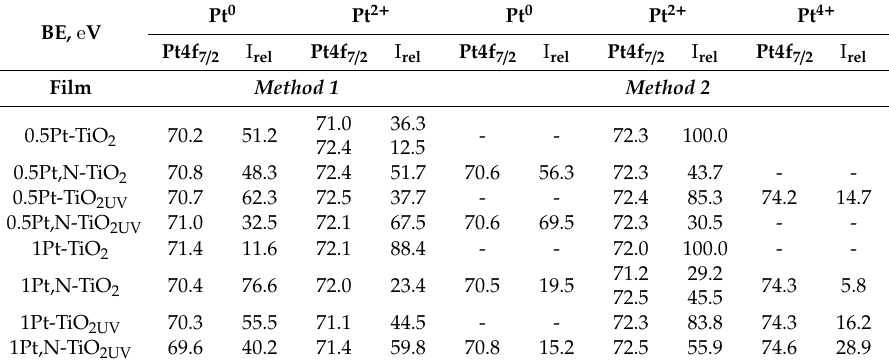
Figure 6. Pt4f XPS spectra of the films: ( a , b ) Method 1 and ( c , d ) Method 2 without ( a , c ) and with ( b , d ) UV pretreatment. Table 4. The position of XPS deconvoluted Pt4f peaks and their relative intensity.